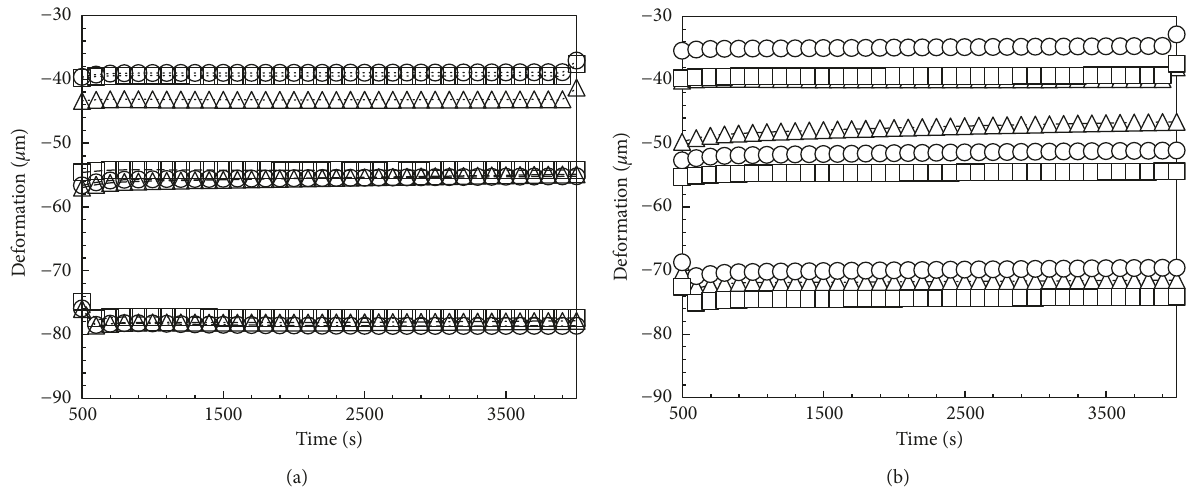
Figure 3: Typical Al-Zn matrix composite deformation curves at 125 ° C, 125 ° C, and 125 ° C as a function of time for (a) 5 wt.% Zn and (b) 10 wt.% Zn (triangles � 0 vol.% AlB